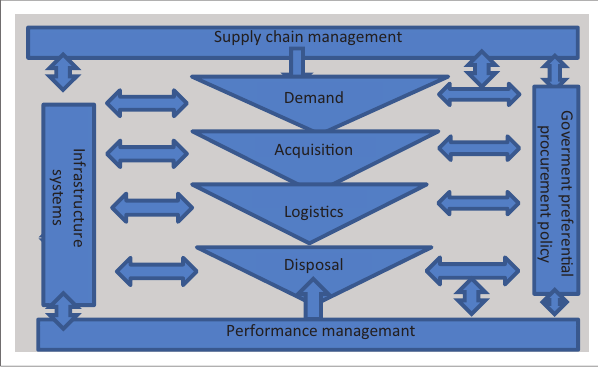
FIGURE 2: Supply chain management